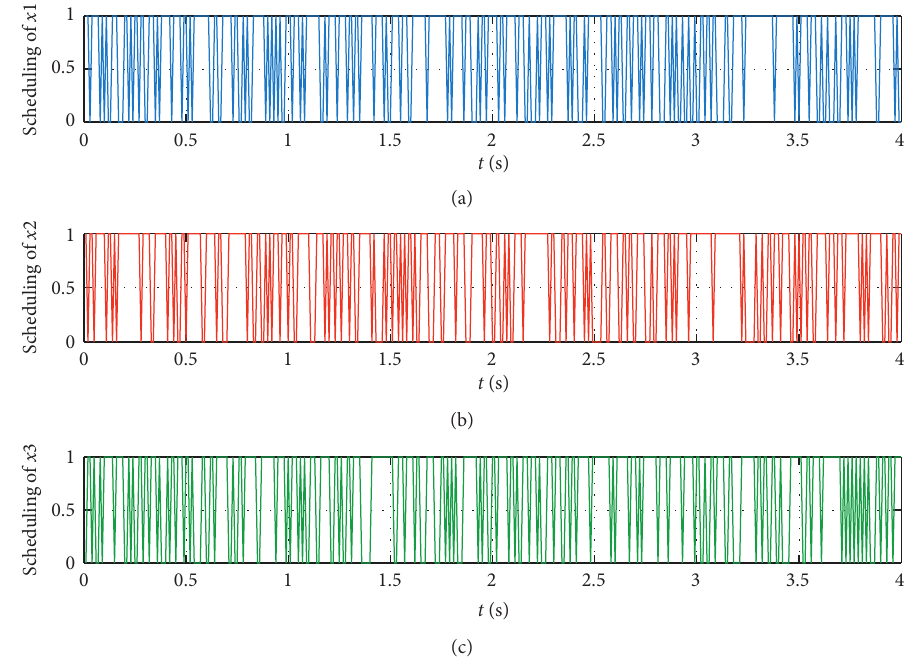
Figure 6: The corresponding transmission waveform of state noncooperative game